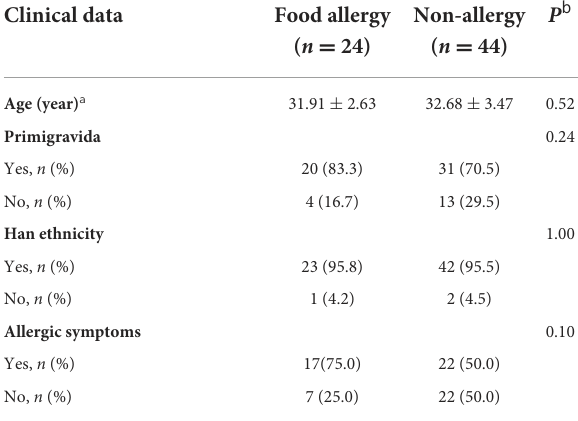
TABLE 1 Clinical data of maternal participants. TABLE 2 Clinical data of infant